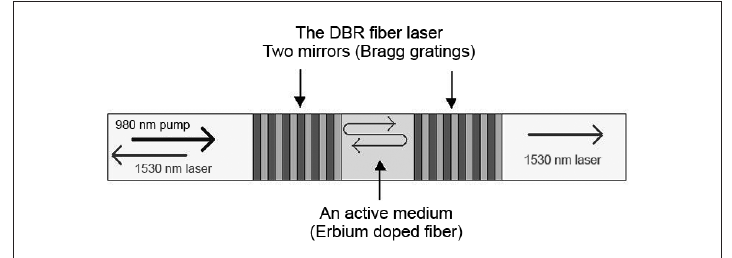
Fig. 3. Fiber laser pumping